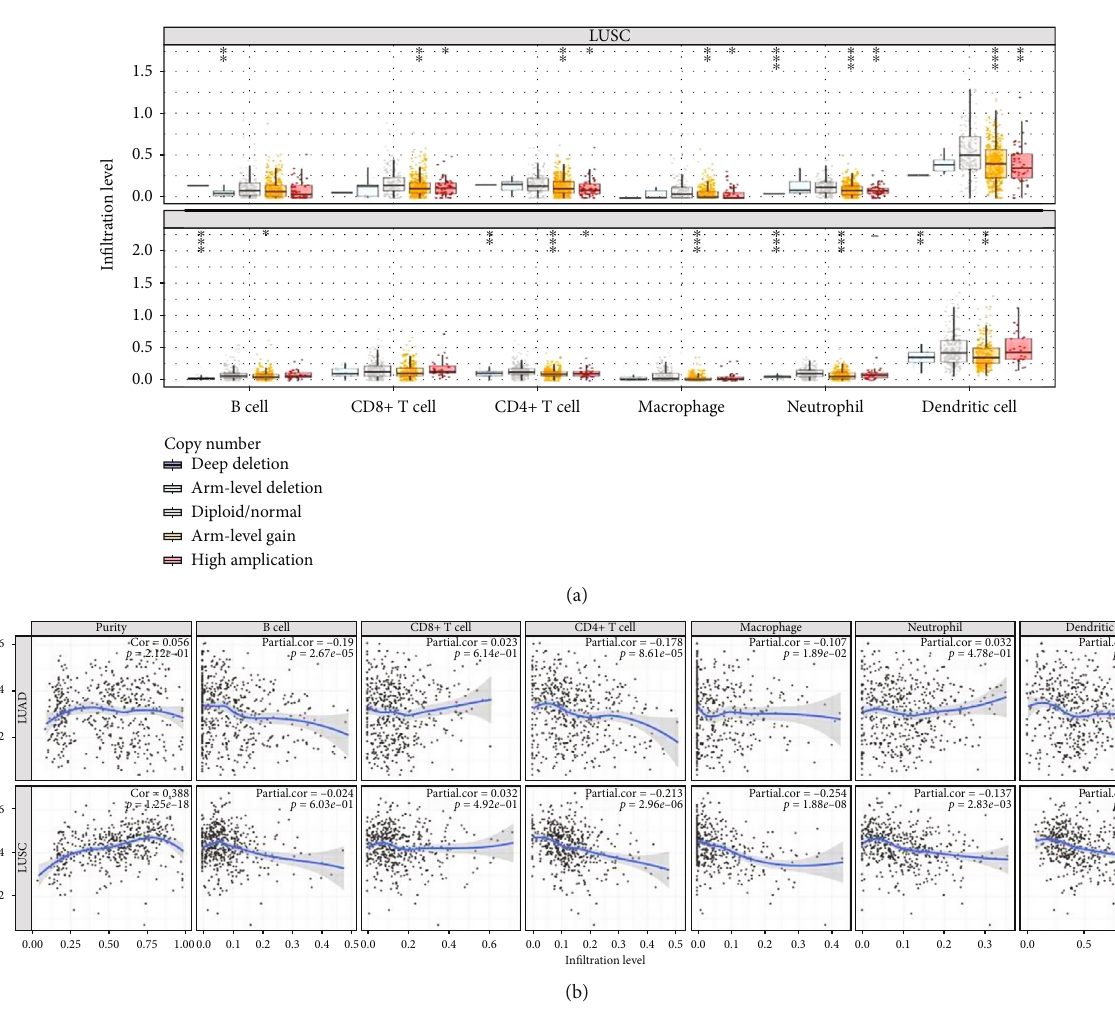
Figure 8: (a) Use the TIMER website (https://cistrome.shinyapps.io/timer/) to explore the correlation between tumor immune cell in fi ltration and somatic cell copy number of NUF2 in LUAD and LUSD, respectively. According to the copy number of NUF2, samples are divided into fi ve categories (deep deletion, arm-level deletion, diploid/normal, arm-level gain, and high amplication); compare the distribution of immune cells in fi ltrated among the fi ve types of samples. P value signi fi cant codes: ∗∗∗ P < 0 : 001 , ∗∗ P < 0 : 01 , and ∗ P < 0 : 05 . (b) Use the TIMER website (https://cistrome.shinyapps.io/timer/) to view the correlation between immune cell and tumor purity and NUF2 expression in LUAD and LUSD in the TCGA